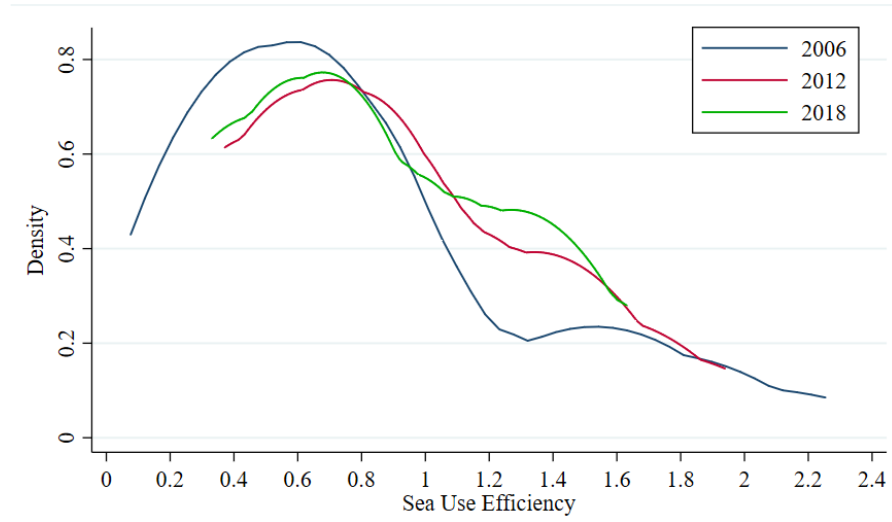
Figure 1. Kernel density analysis of SUE.